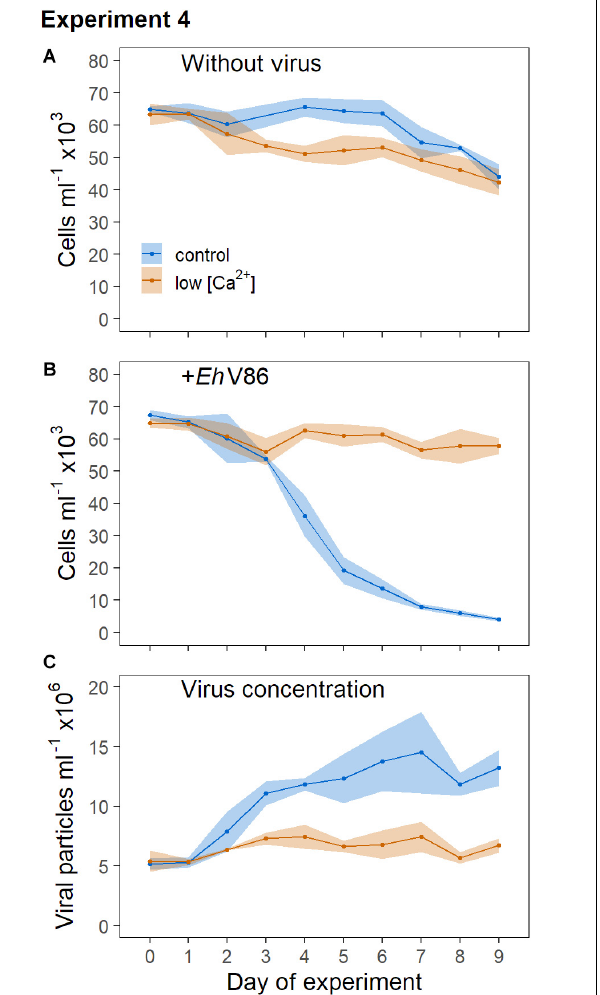
FIGURE 5 | Addition of virus to calcified and decalcified cells in permanent darkness. Sample mean ± 95% CI ( n = 3). (A) Concentration of calcifying E. huxleyi CCMP1516 without virus and (B) when virus was added; (C) concentration of viral particles.